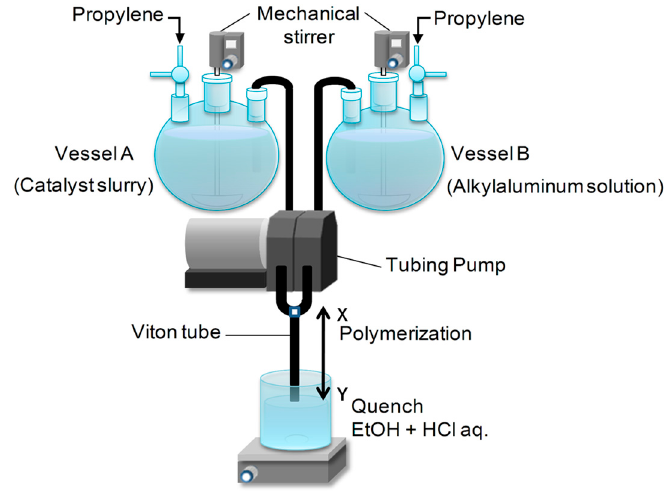
Figure 3. Two-vessel large-scale stopped-flow (LSF) apparatus [21].